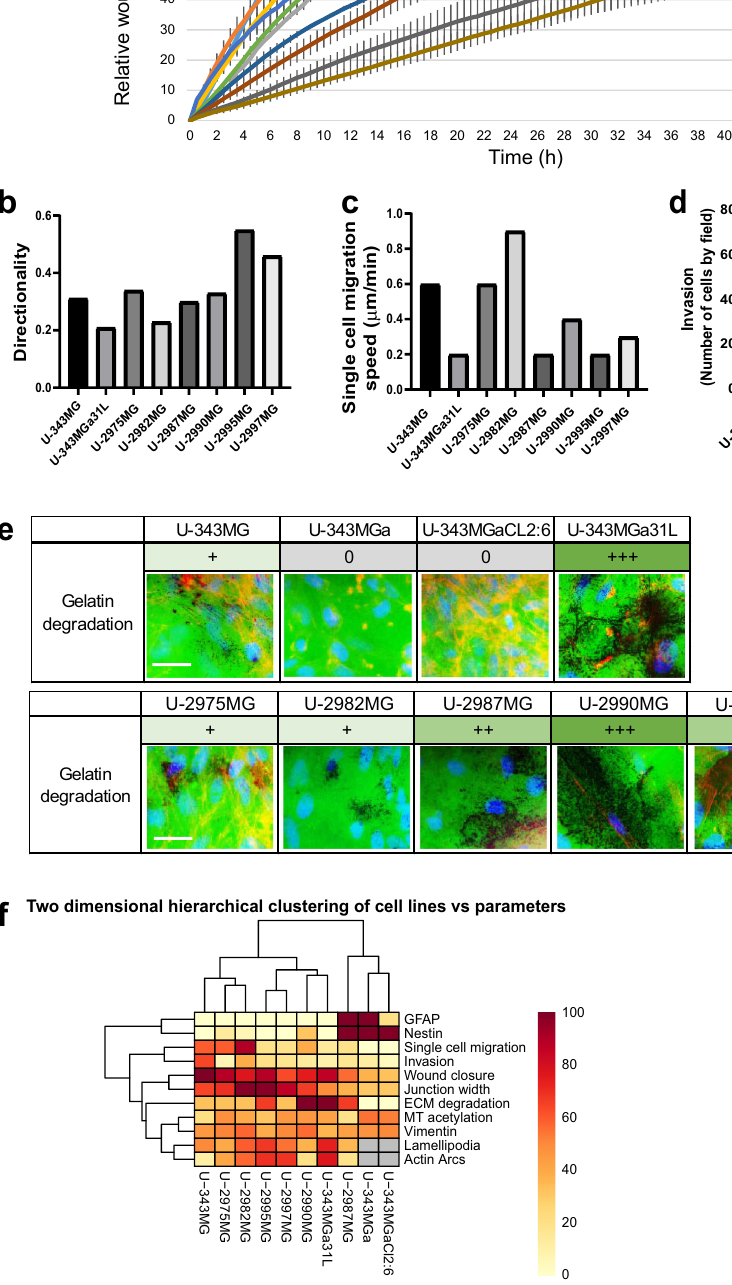
Figure 3. Migratory and invasion properties. ( a ) Quantification of wound closure over 48 h, using the IncuCyte imaging device. ( b,c ) Quantification of migration speed ( b ) and directionality of migration ( c ), performed for 25 cells per cell line using the Tracking Tool software. ( d ) Quantification of invasion, using cell migration through Transwell filters coated with Matrigel, and performed as three independent experiments, with statistical significance calculated with ANOVA-Tukey’s post-hoc tests and summarized in Supplementary Table S7. ( e ) Representative images of matrix degradation activity 48 h after seeding cells on coverslips coated with FITC-labeled gelatin, with estimated degradation activities given as 0 (no degradation) to + + + (high degradation). ( f ) Summary results of the phenotypes for the glioblastoma cell lines, shown as two-dimensional hierarchical clustering of cell lines versus